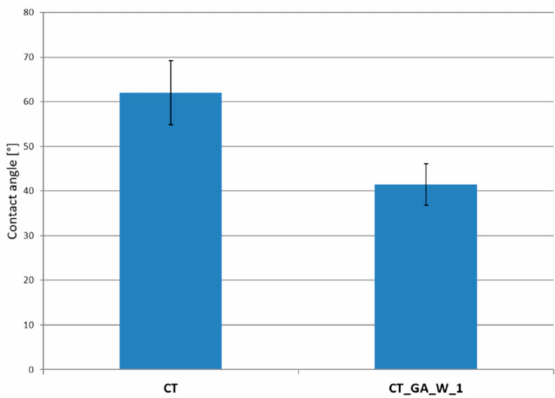
Figure 5. Contact angle measurement before and after the